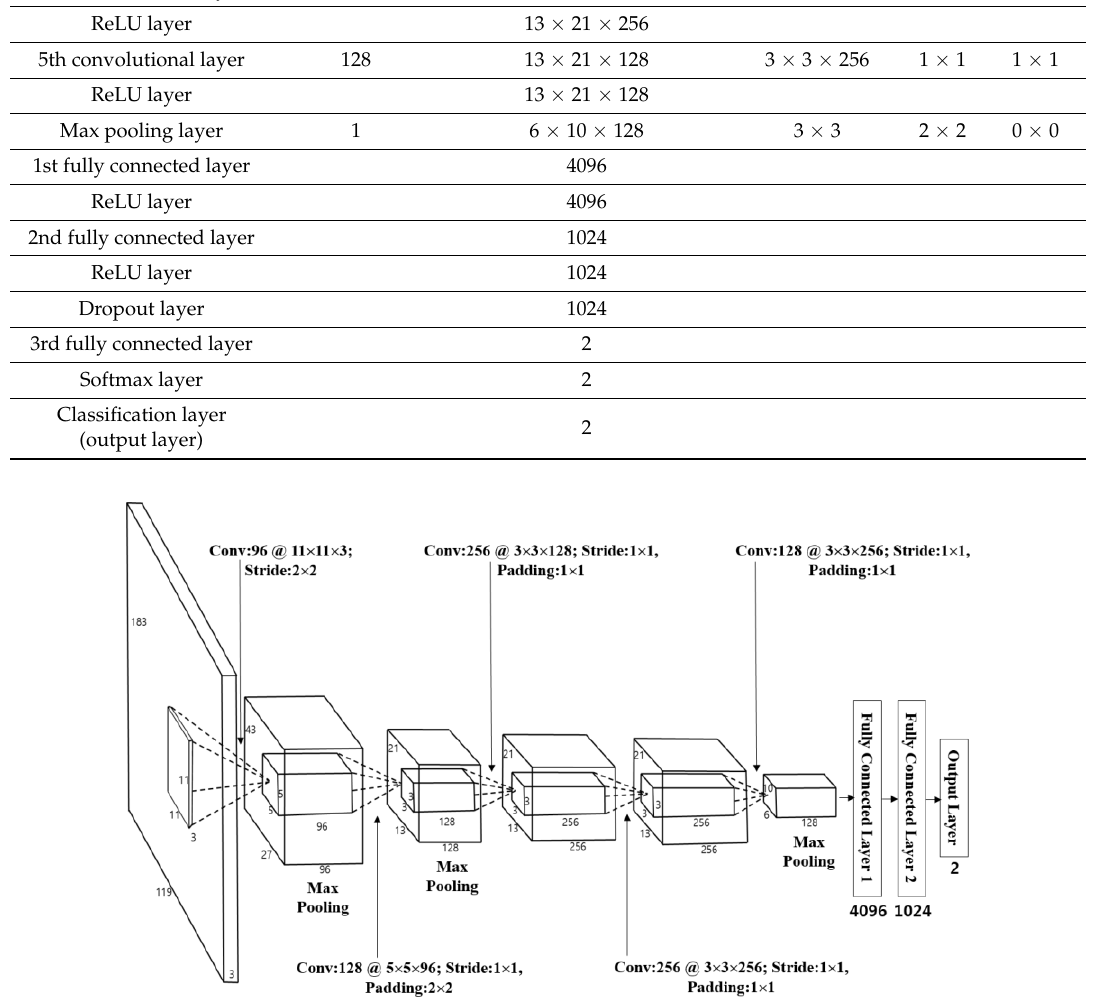
Figure 7. The CNN architecture.